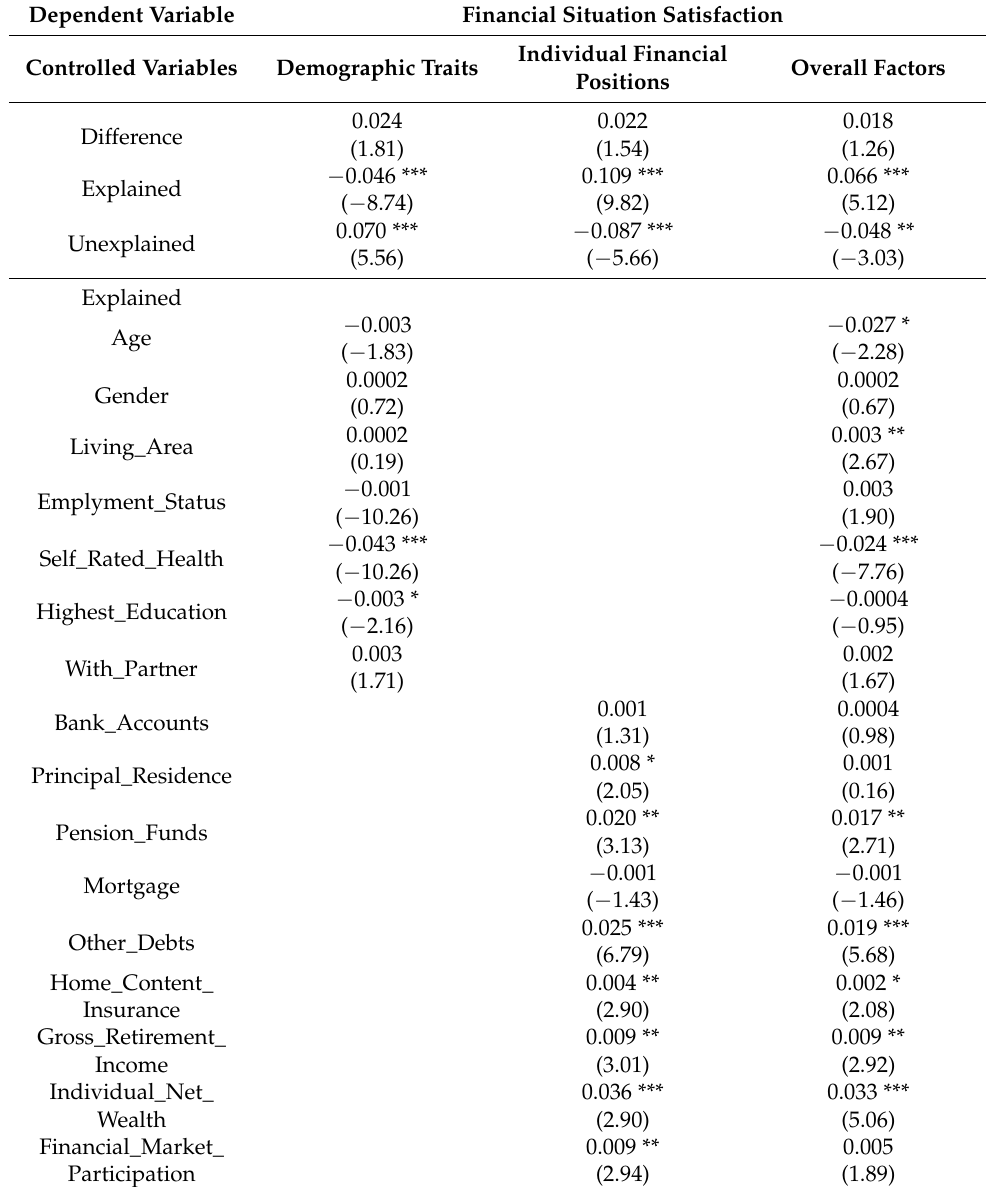
Table 7. Retiree financial situation satisfaction decomposition in Australia and New